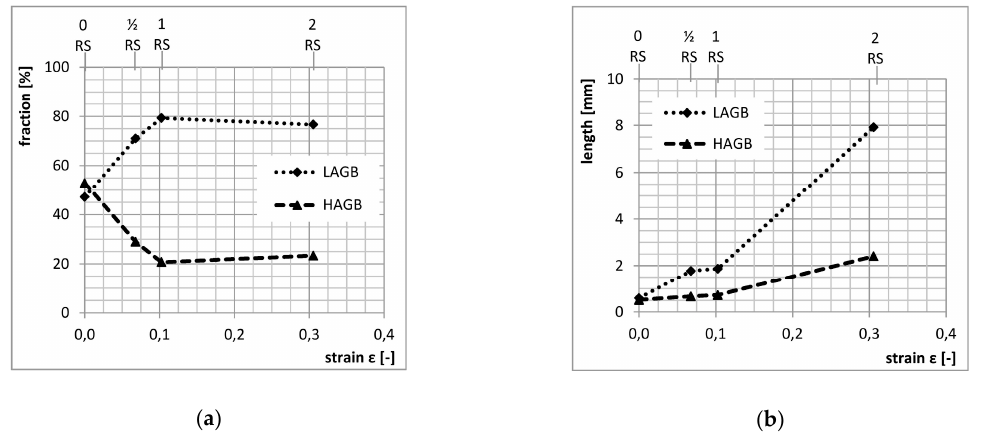
Figure 8. Quantitative evaluation of LAGB and HAGB: ( a ) fraction of LAGB and HAGB vs. strain and ( b ) total length of LAGB and HAGB vs. strain.